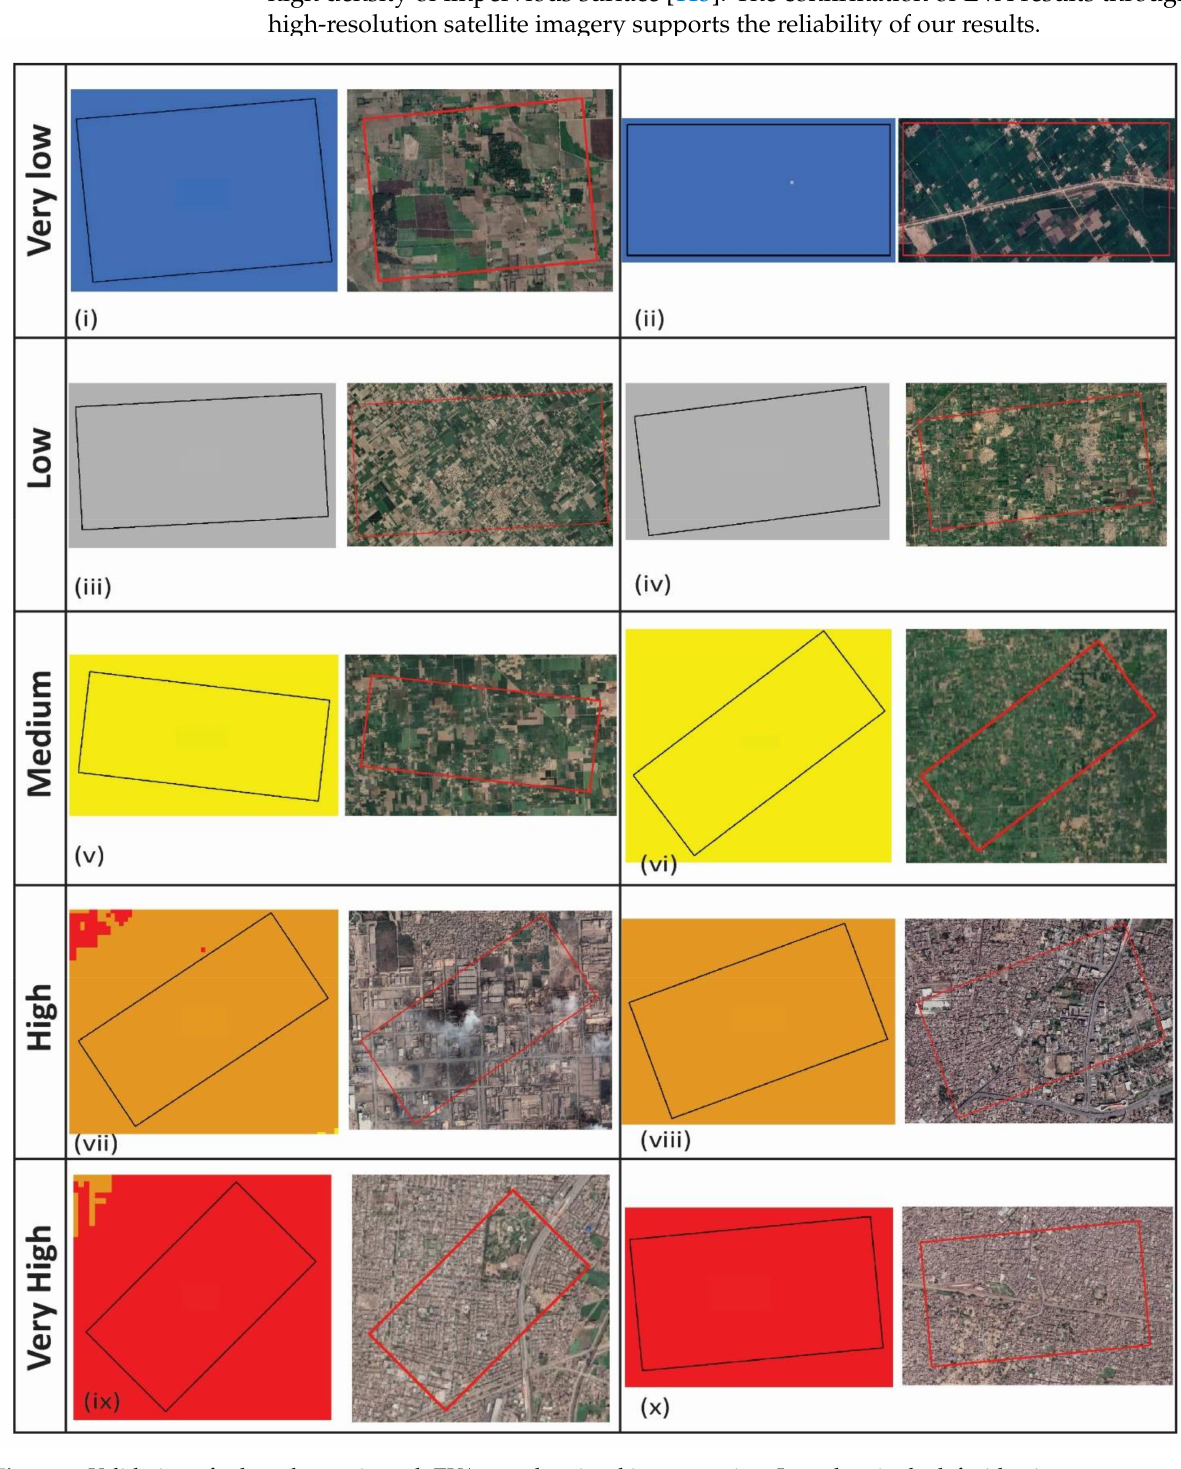
Figure 9. Validation of selected areas in each EVA zone by visual interpretation. In each pair, the left side picture represents the output by our EVA model, and the right-side immediate picture shows a satellite view of the same